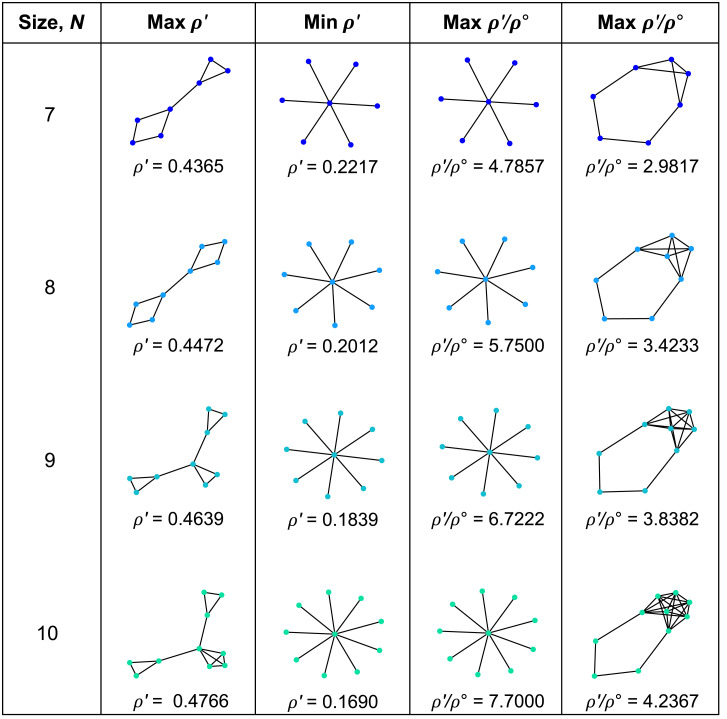
Small graphs with extreme effects for temperature initialization.The graphs with the largest or smallest values of ρ′ (which characterizes the likelihood of selected mutations to become fixed), and ρ′/ρ∘ (which quantifies the balance of selection versus drift) are shown for sizes 7 to 10. The Star graph minimizes ρ′ but maximizes ρ′/ρ∘ for these sizes. The largest ρ′ values arise for graphs with multiple components joined by single edges, while the smallest ρ′/ρ∘ ratios occur for Detour graphs.